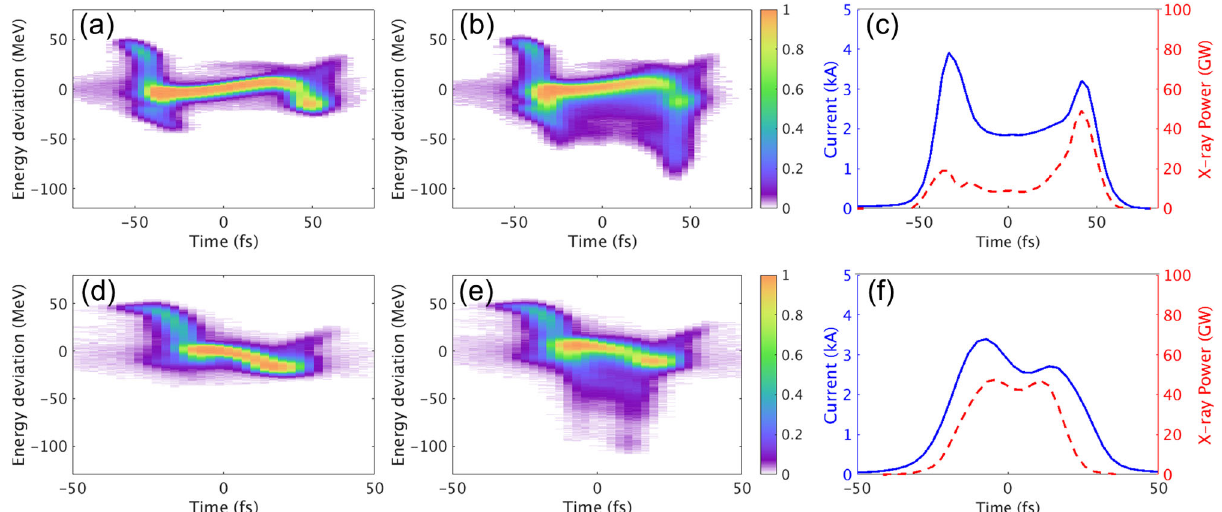
FIG. 5. Measurement examples of the final beam without collimation for hard x-ray FEL case. Electron beam energy is 13.5 GeV, and bunch charge is 250 pC (top row) and 150 pC (bottom row), respectively. (a) – (c): bunch charge 250 pC, the electron beam longitudinal phase space for lasing-off condition (a) and lasing-on condition(b), and the beam current profile and reconstructed FEL power profile in (c). (d) – (f): bunch charge 150 pC, same measurement as 250 pC case. In both cases the x-ray pulse energy is ∼ 2 mJ. Data taken on 11/ 16 –